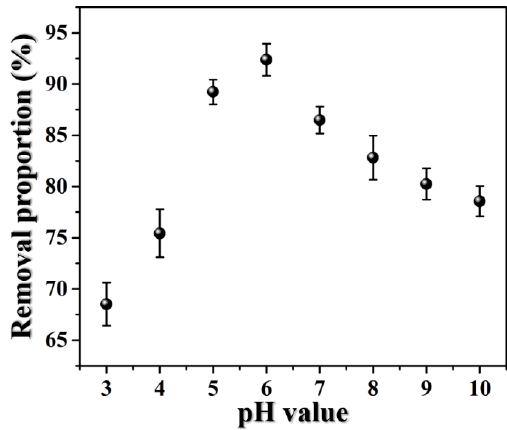
Figure 7. Effect of pH on the adsorption of RhB by magnetic carbon foam. Figure 7. E ff ect of pH on the adsorption of RhB by magnetic carbon